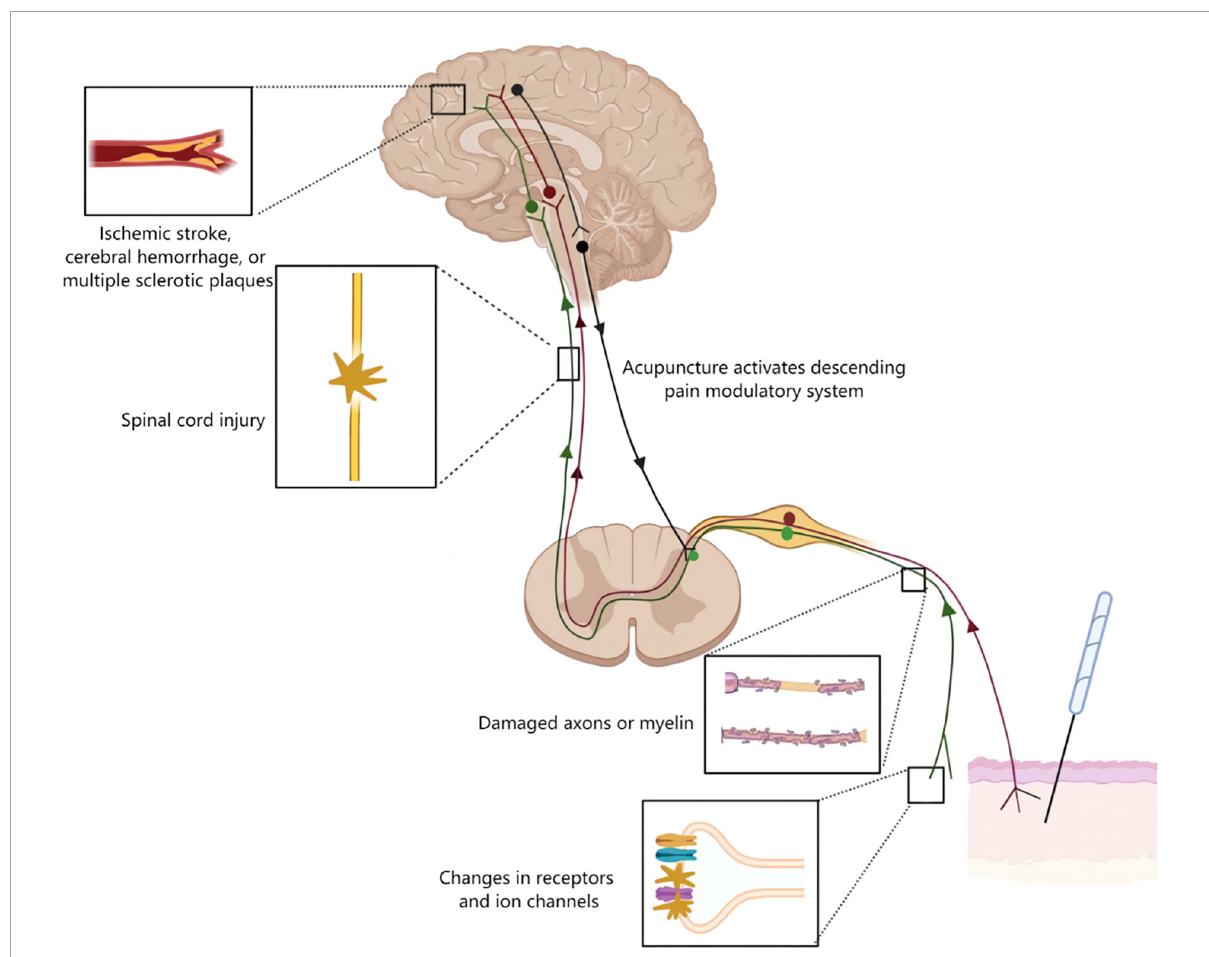
FIGURE4 Acupuncture mechanisms on neuropathic pain. Neurological damage from peripheral to the cortical brain may lead to neuropathic pain. The figure shows four typical examples of lesions. Alterations in receptors and ion channels impact neuronal function, resulting in spontaneous (ectopic) activity and pain. Along the peripheral nerve different types of lesions may damage either the entire nerve or selectively the axons or myelin causing axonal or demyelinating neuropathies, respectively. Lesions of the spinal cord or brain as seen for example following traumatic injury, ischemic stroke, cerebral hemorrhage, or multiple sclerotic plaques may lead to central neuropathic pain. Acupuncture inhibited pain transmission via the somatosensory system, and activated the descending pain control